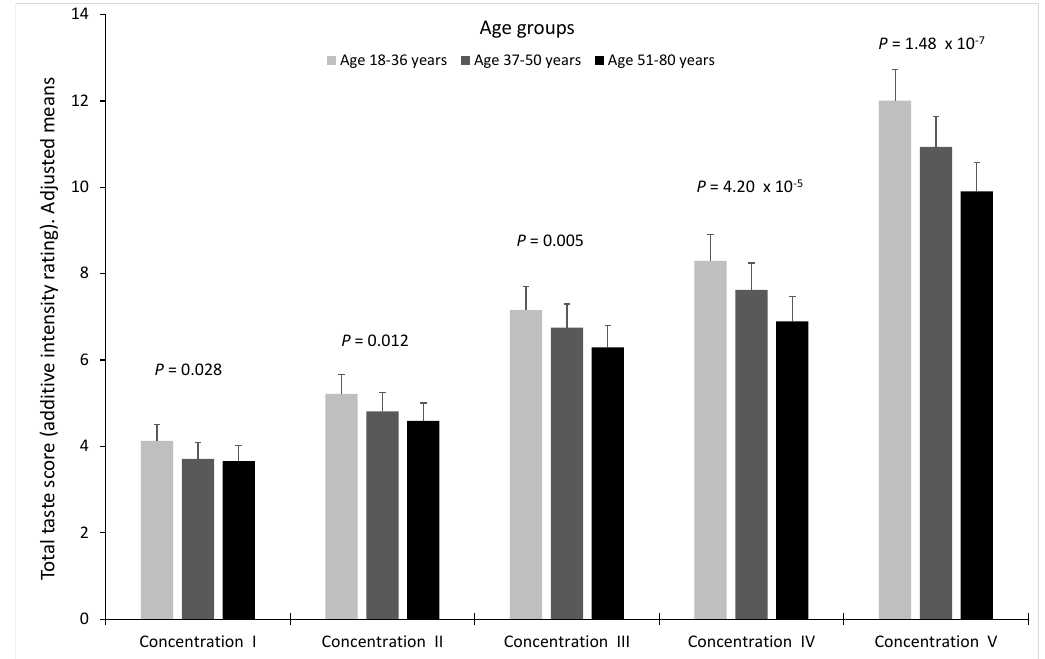
Figure 1. Total taste score (sum of intensity ratings of the five tastes) by age group and the increasing concentrations (from I to V) of the tastants tested ( n = 1019, 1016, 1014, 1016 and 1020 for the concentrations I, II, III, IV and V), respectively in the whole population). Values are adjusted means (model 3) including sex, age, diabetes, body mass index, smoking and medications. Age groups are based on tertiles. p -values show the statistical significance for the age differences in total taste perception for each concentration after adjustment for covariates (model 3). Error bars are SE. Age groups: 18–36 years ( n = 342), 37–50 years ( n = 329) and 51–80 years ( n =